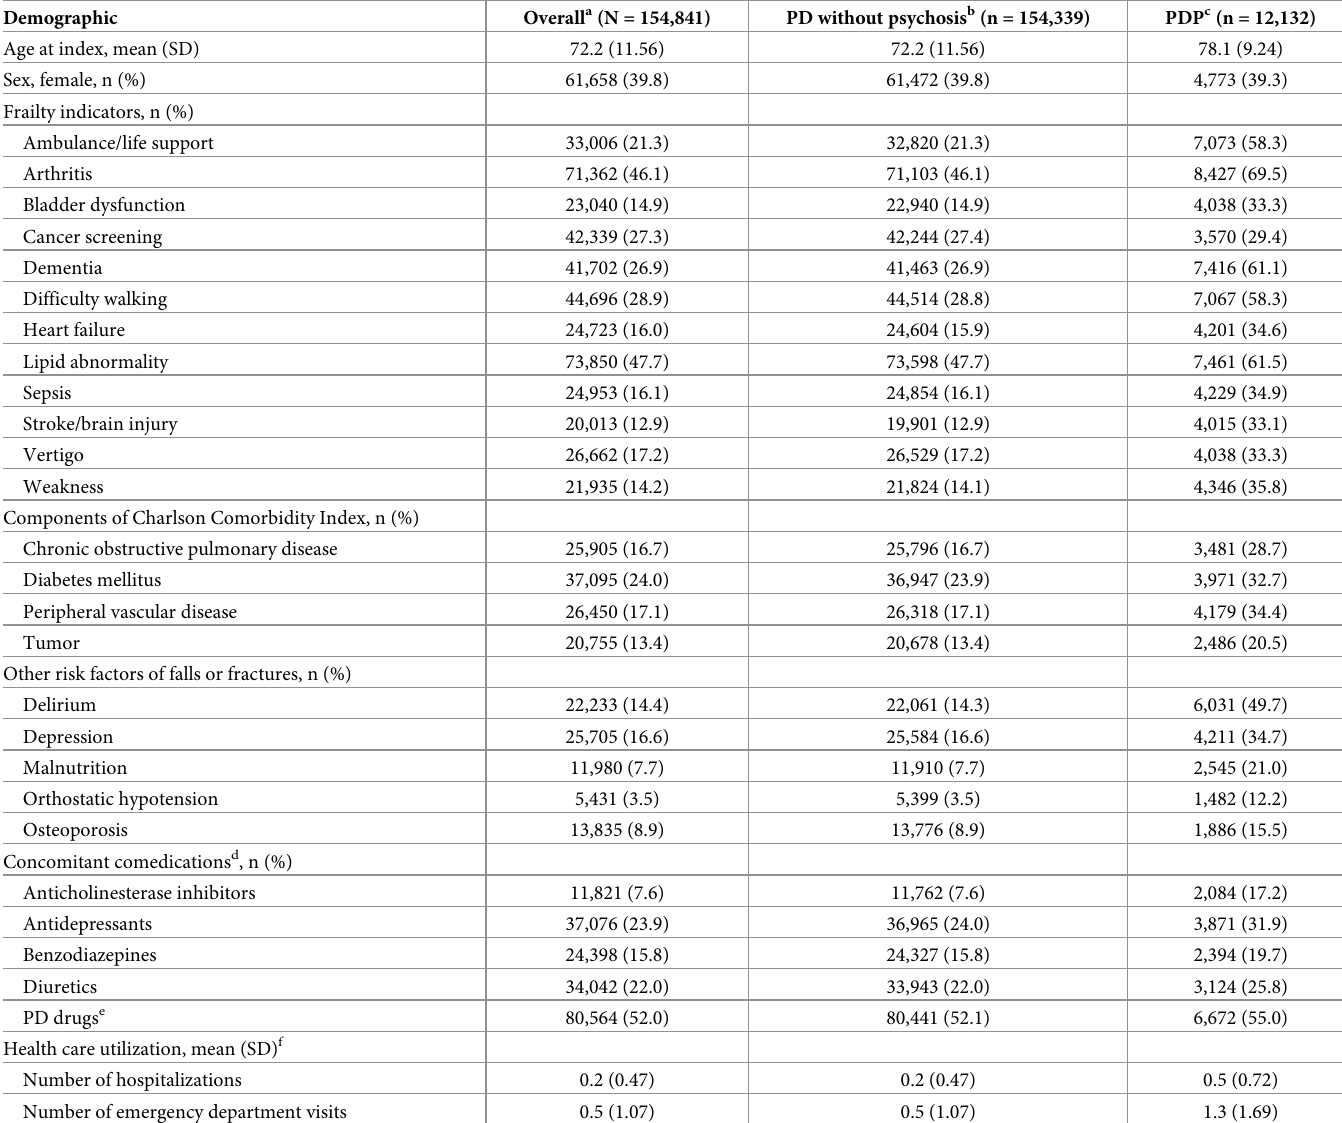
Table 1. Descriptive characteristics (at least in 10% of patients) of patients with PDP and patients with PD without psychosis, before matching.